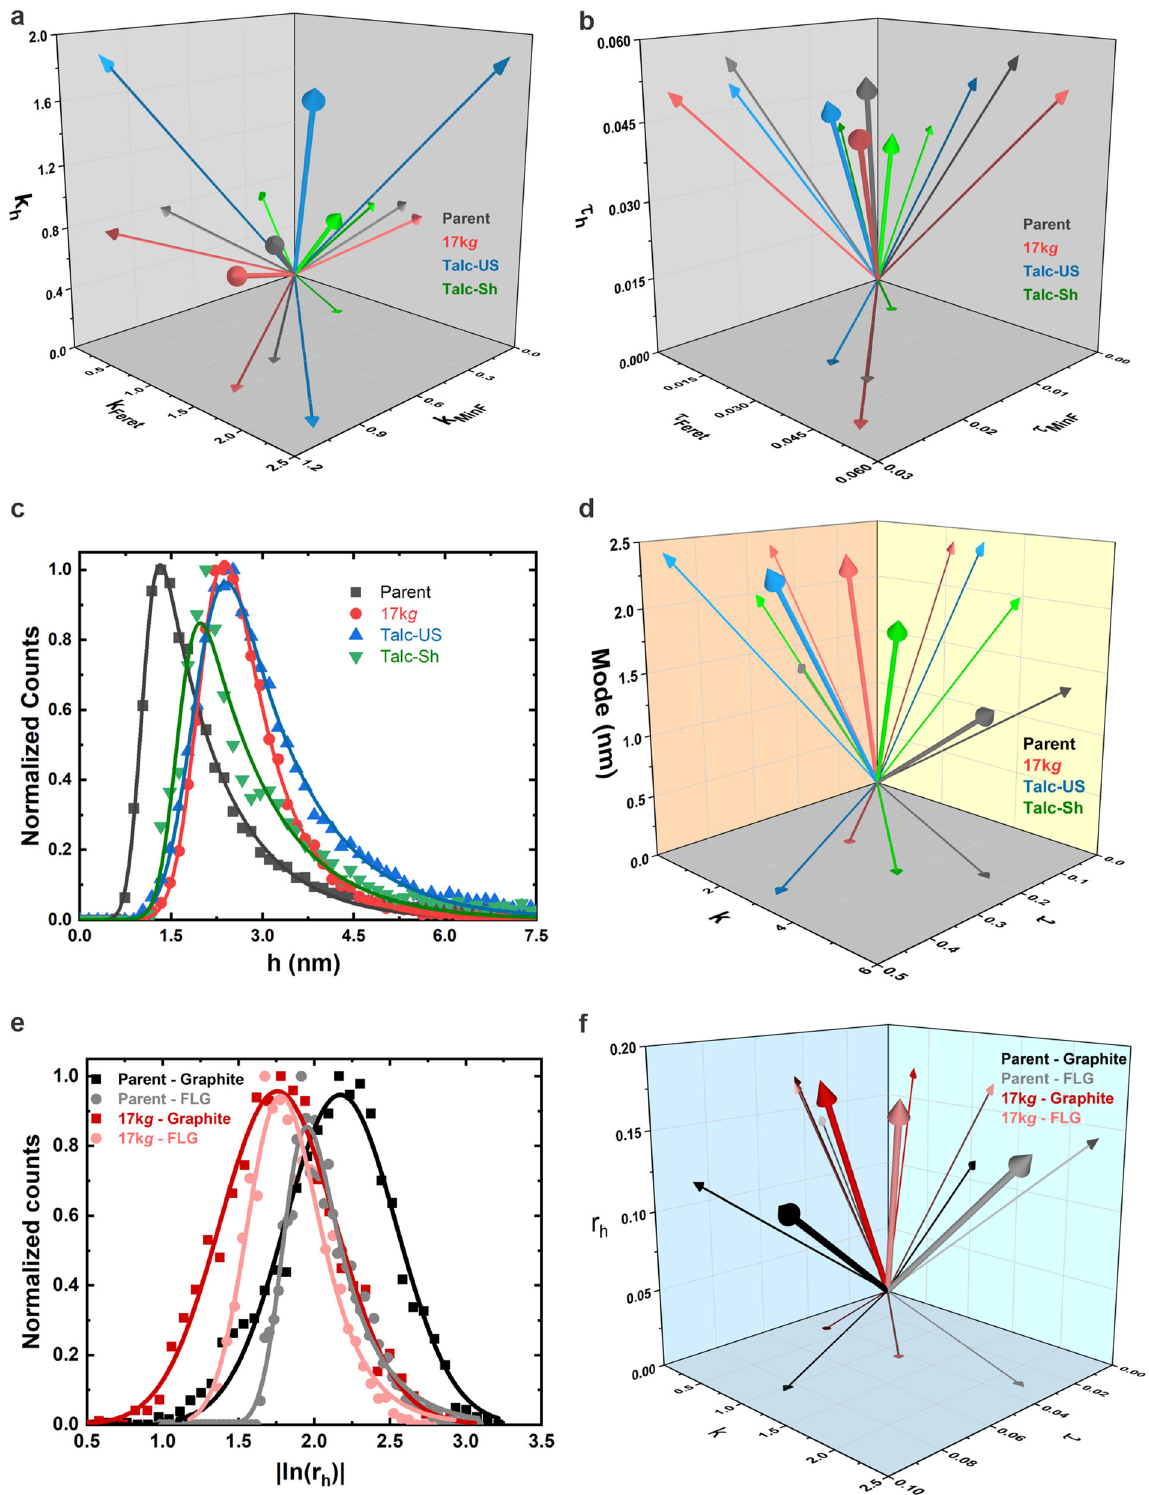
Fig. 3 Distribution shape vectors k and τ and normalized distributions of fl ake thickness h and partitioned r h , including their respective vectorial representations. a k -shape vectors with components k h , k Feret , and k Minf for all four systems. b Trimness vectors with components τ h , τ fl ake thickness h for each system. d Vectorial plot of the three characteristic τ Feret , and Minf for all four systems. c Normalized histogram of parameters of each distribution: mode, k and τ . e: Normalized histogram of ln(r h ) for the Parent and 17 k g samples partitioned into FLG and graphite fl akes. In Panel a through d : Parent — black; 17 k g — red; Talc-US — blue and Talc-Sh — green. In panels e and f : Parent-Graphite — black; Parent-FLG — Gray; 17 k g -Graphite — red; 17 k g -FLG — pink. The projections along each plane are also shown in a, b, d, f .